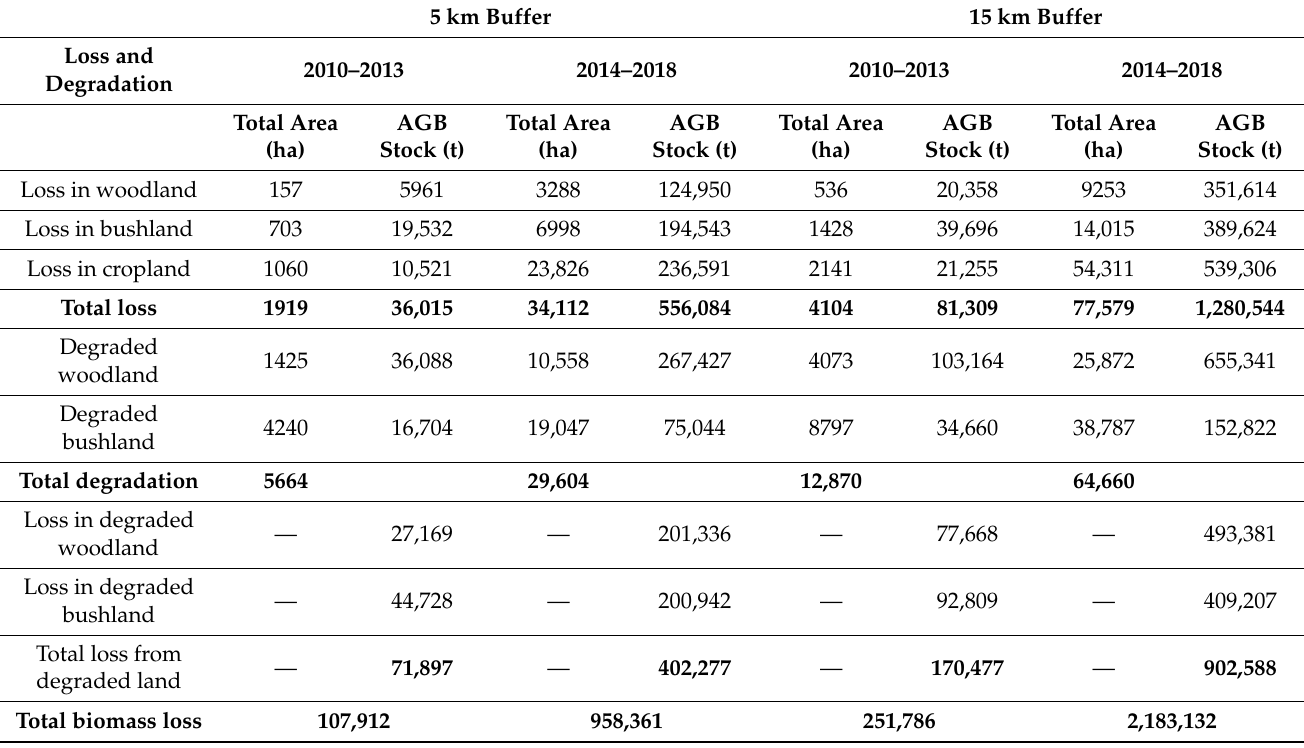
Table 9. Loss and degradation (ha) and biomass (AGB) changes in selected land cover classes within 5 and 15 km of the refugee settlement boundaries in northern Uganda.